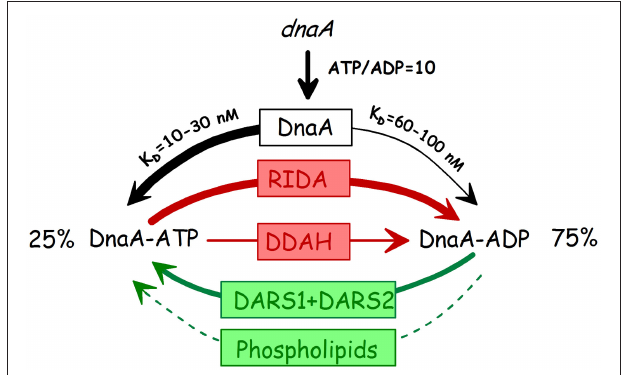
FIGURE 13 | The three states of the DnaA protein. The thickness of the arrows indicate the approximate relative contributions of the different elements to the interconversion of the different forms. Stipled arrow: the relative contribution of phospholipid mediated nucleotide exchange (Sekimizu and Kornberg, 1988; Aranovich et al., 2006, 2015) is unknown. RIDA: Replicative inactivation of DnaA (Katayama et al., 1998; Kato and Katayama,